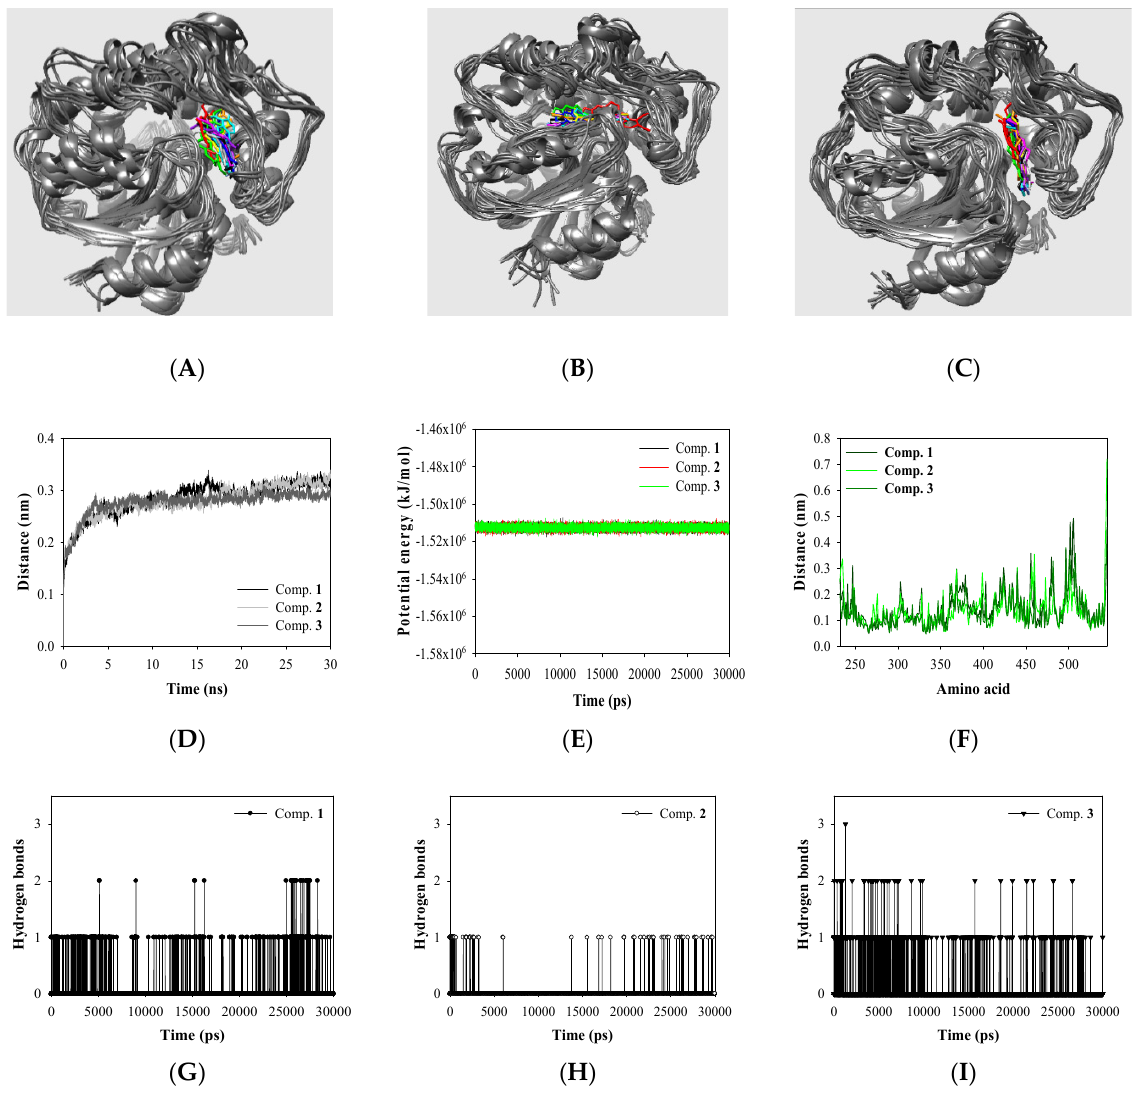
Figure 4. The superpositions of inhibitors 1 – 3 ( A – C ), the RMSD ( D ), potential energy ( E ), RMSF ( F ), hydrogen bonds ( G – I ) of the simulation calculated during 30,000 ps. hydrogen bonds ( G – I ) of the simulation calculated during 30,000